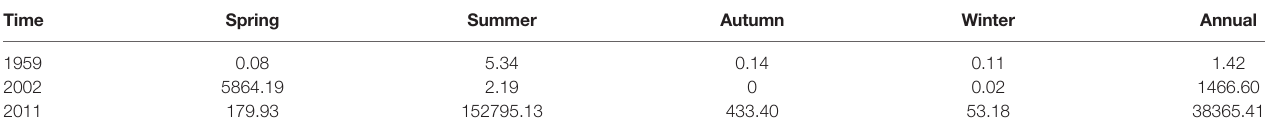
TABLE 5 | Comparison of the net-collected abundance of N. scintillans (cells/m 3 ) in different years in the Changjiang Estuary (28°00 ’– 32°00 ’ N, 122°00 ’– 123°30 ’ E). Time Spring